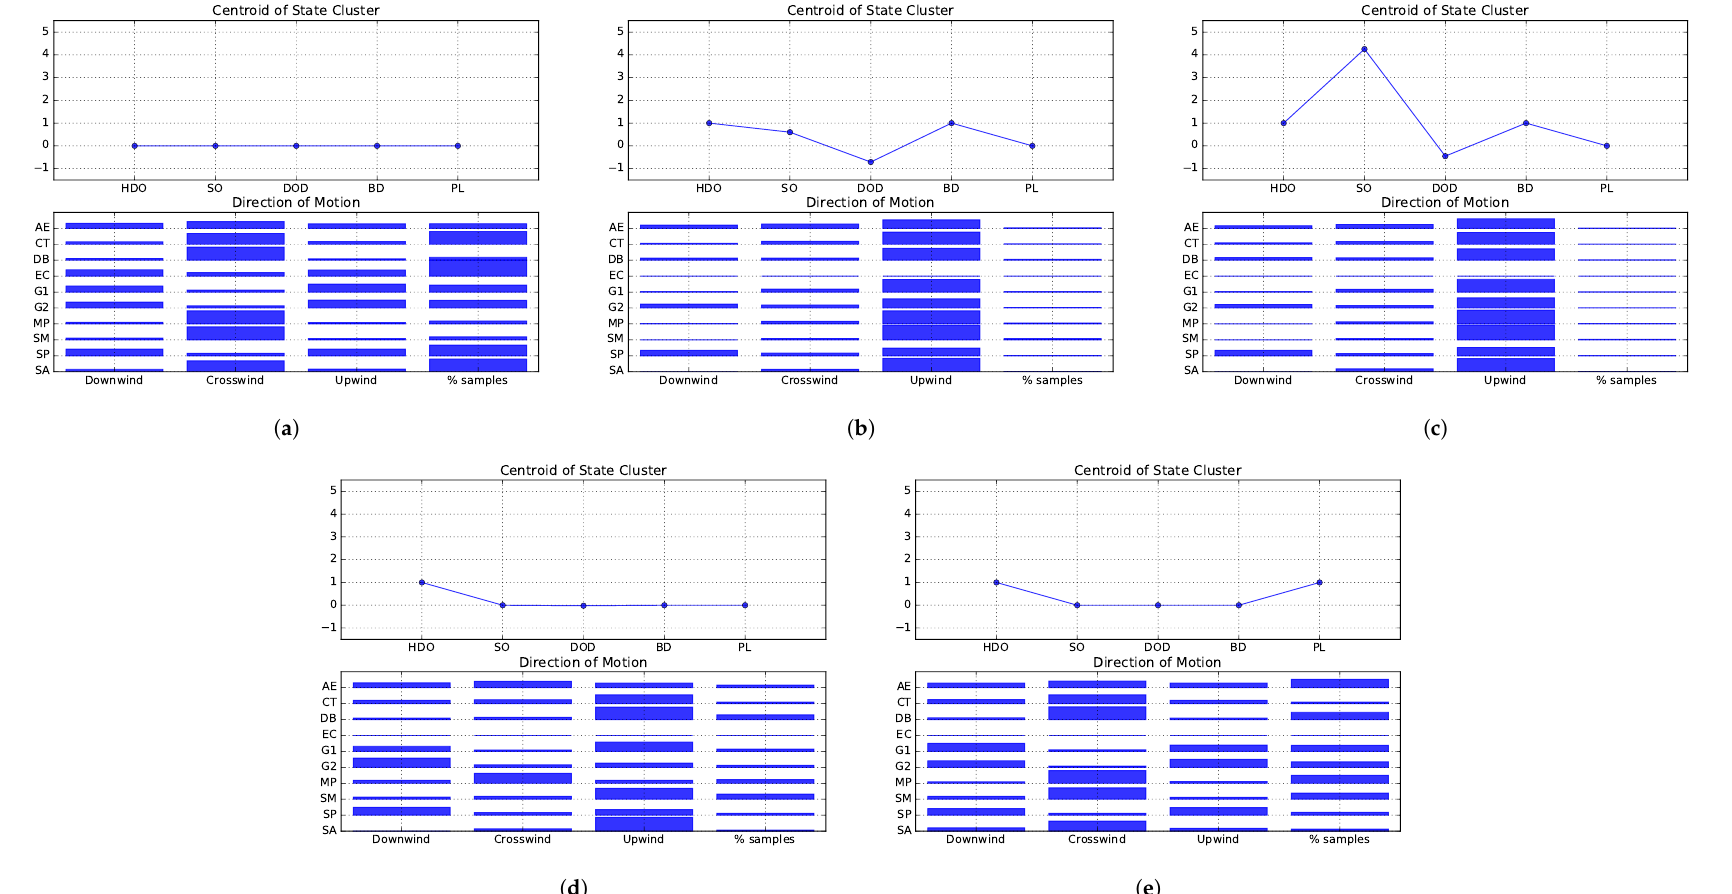
Figure 7. 5 state-action mappings for environment 1. The top of each sub-figure presents the centroid of the respective state cluster. The bottom of each sub-figure presents the stacked histograms of relative frequency of the actions taken by each strategy in the respective state. A fourth bar is added to the histogram of each strategy, representing the percentage of simulation steps spent perceiving the corresponding state. ( a ) State 1: the robot has yet to detect any odour concentration; ( b ) State 2: the robot is sensing low concentrations of odour; ( c ) State 3: the robot is detecting high concentrations of odour; ( d ) State 4: the robot has recently lost contact with the chemical plume; ( e ) State 5: the robot has not detected odour for an extended time